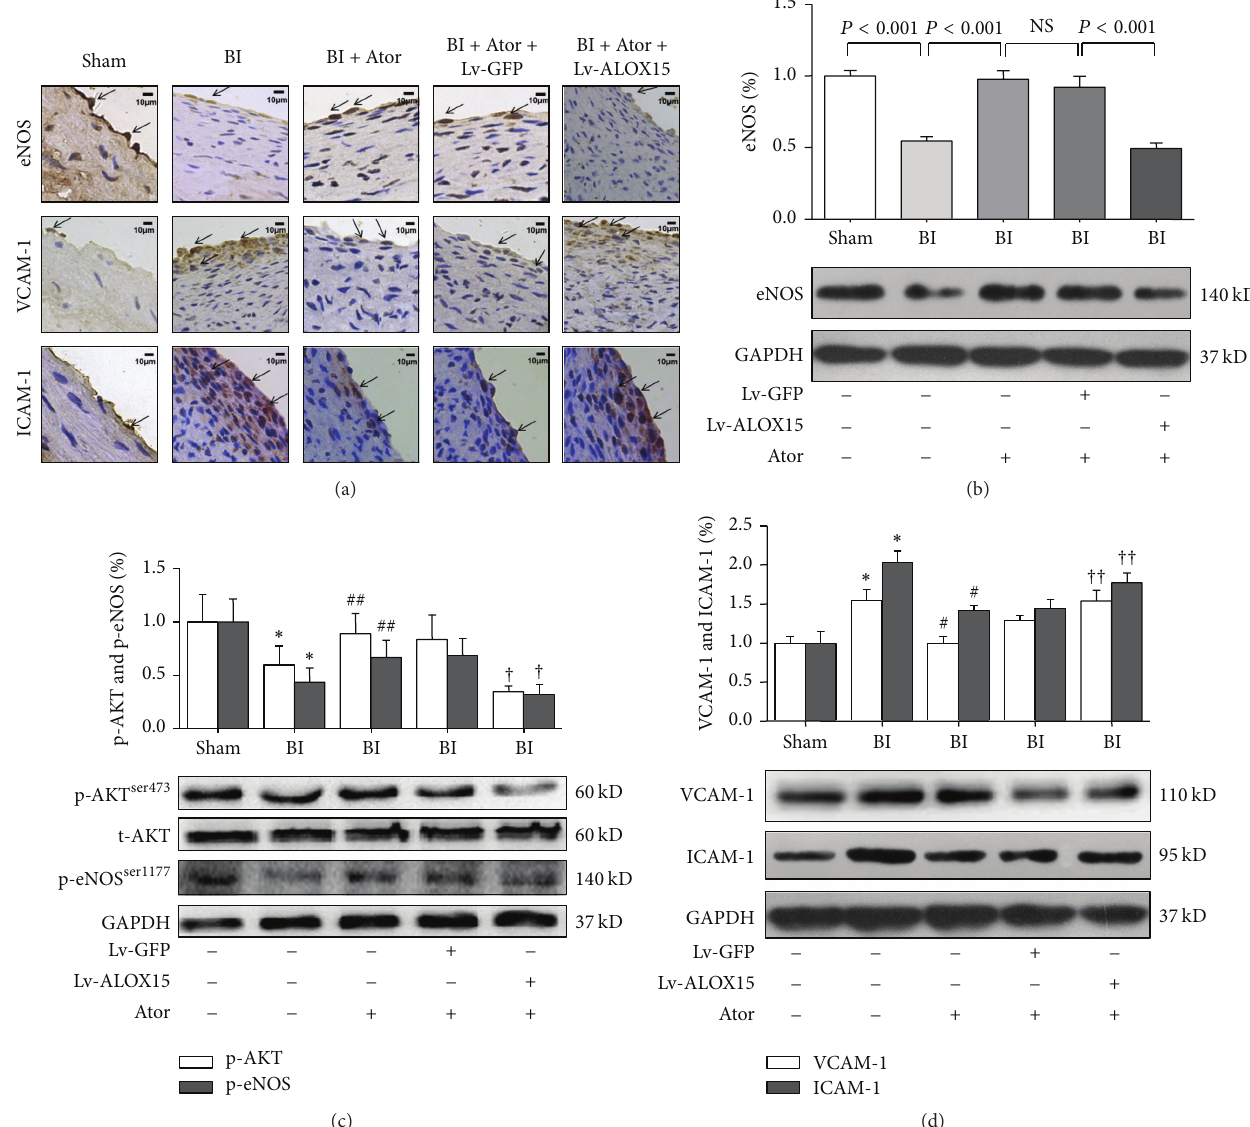
Figure2:ExpressionlevelsofAKT,eNOS,VCAM-1,andICAM-1weremodulatedbylentivirus-basedALOX15overexpressioninratballoon- injured (BI) carotid arteries 14 days after transfection. (a) Immunohistochemical analysis of eNOS, VCAM-1, and ICAM-1 in BI carotid arteries. The arrows indicate positive staining. The scale bar represents 5 𝜇 m. (b) Western blot analysis of eNOS expression in BI carotid arteries. (c) Western blot analysis of p-AKT/p-eNOS expression in BI carotid arteries to assess the activity levels of AKT and eNOS. The protein level of p-eNOS was normalized against that of GAPDH because total eNOS expression was changed. (d) Western blot analysis of VCAM-1/ICAM-1 expression in BI carotid arteries. The scale bar represents 10 𝜇 m. Results are expressed as mean ± SD. Ator: atorvastatin; NS: not significant. ∗ 𝑃 < 0.01 versus the Sham group; # 𝑃 < 0.001 and ## 𝑃 < 0.05 versus the BI group; † 𝑃 < 0.01 and †† 𝑃 < 0.05 versus the BI + Lv-GFP group. 𝑁 = 4 per